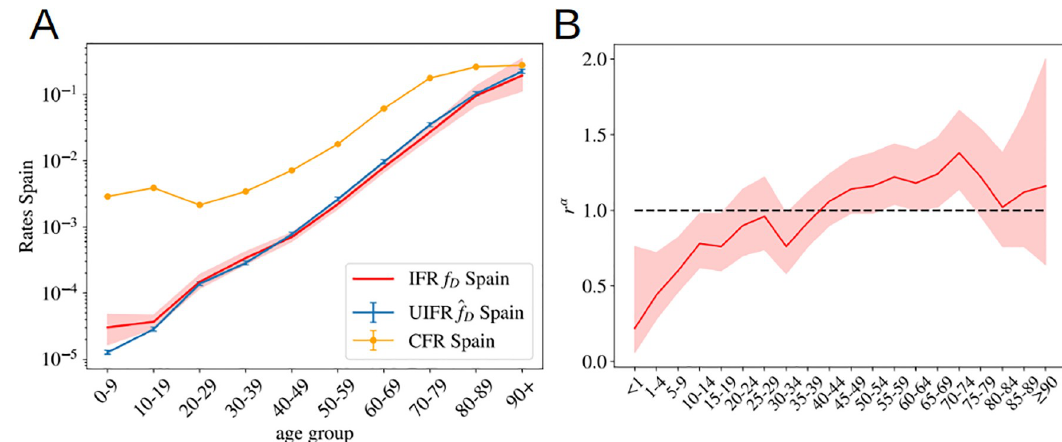
Fig 6. Uniform versus non uniform IFR. A We show the relative risk of infection for an age segment r α (see Eq (4) and definition below) taken from the sero-epidemiological study of the Spanish population [46]. While the youngest segments of the population seem to be less hit by the virus, the distribution of the infections is rather similar to that of a uniform attack rate, indicated by the dashed line r α = 1 here. The 95% confidence interval for r α is indicated by the red shadow. B We show the estimated uniform and nonuniform IFR for Spain and compare it with the CFR as a function of age. The error for the non-uniform IFR is shown by a red